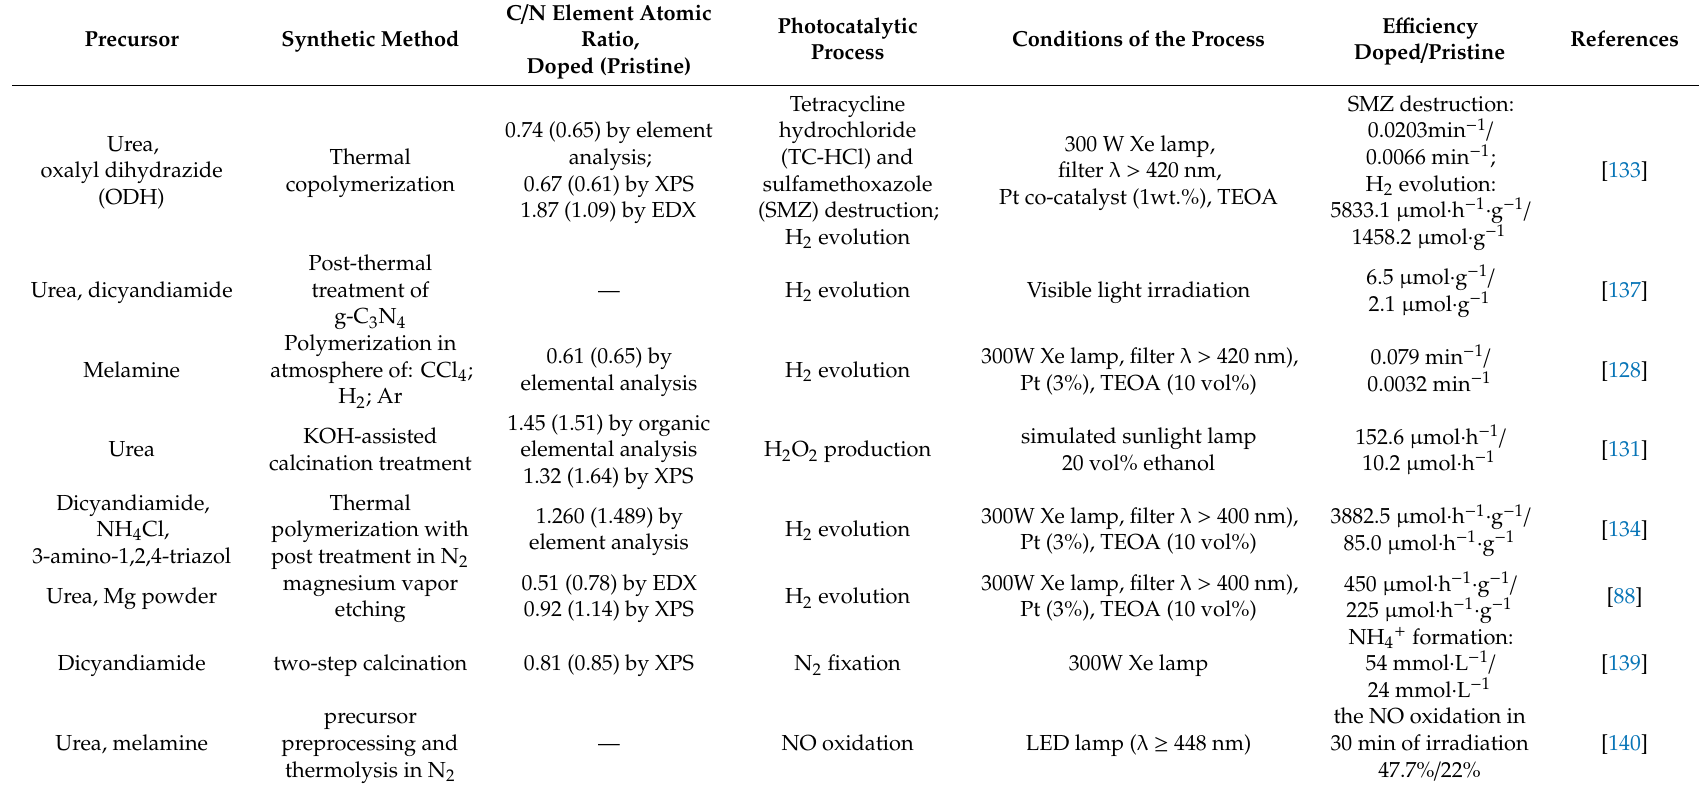
Table 6. Synthetic methods, applications, and photocatalytic e ffi ciency of vacancy-doped g-C 3 N 4